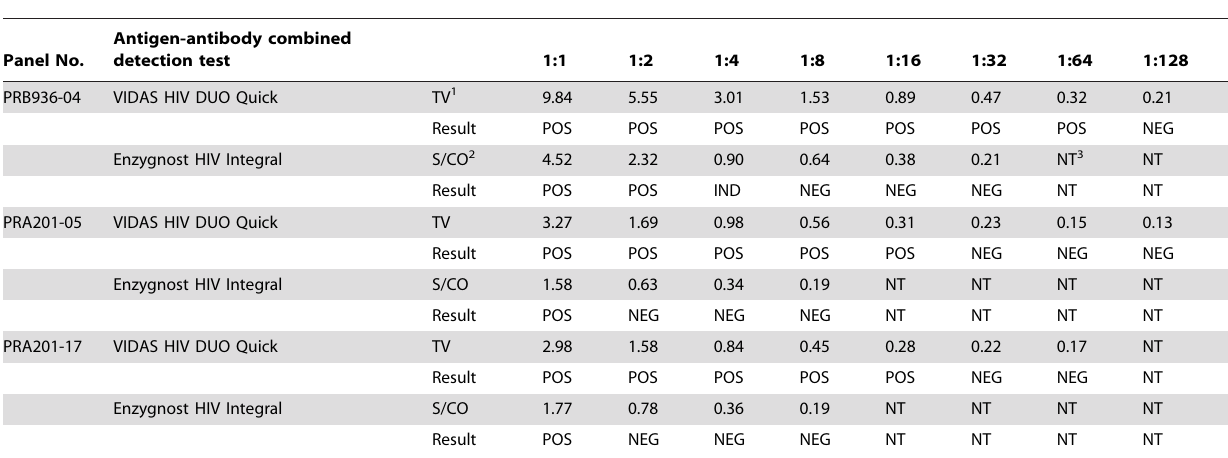
Table 2. Antigen detection limits by antigen-antibody combined detection tests using 3 antigen positive specimens in the panels.